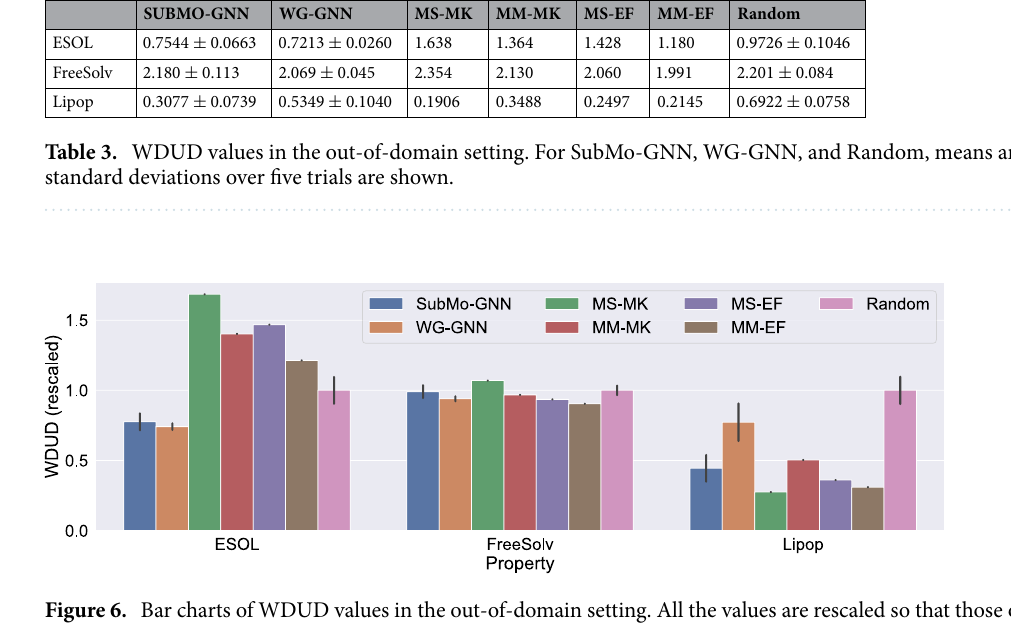
Figure 6. Bar charts of WDUD values in the out-of-domain setting. All the values are rescaled so that those of Random become